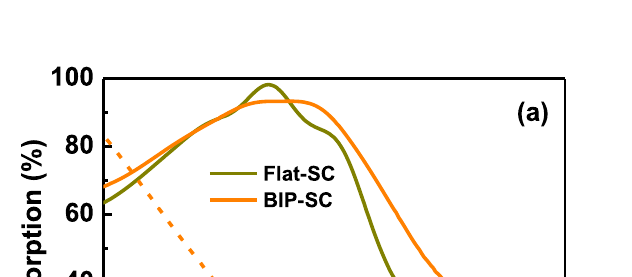
Table 1. Summary of performance characteristics for the n-i-p a-Si:H solar cells fabricated on fl at, inverted pyramids, and buried inverted pyramid back-re fl ector surfaces. The enhancements in J (cid:1) J )/ J ] (cid:3) 100 % and D h = [( h [( J sc-IP(BIP)-SC sc-Flat-SC sc-Flat-SC